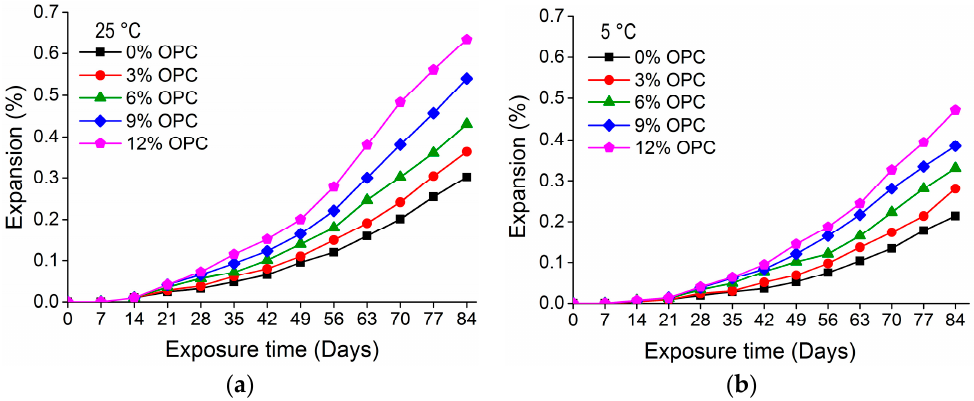
Figure 5. Expansion in nano-TiO 2 containing OPC mortars immersed in 10% Na 2 SO 4 solution at ( a ) 25 ◦ C ( b ) 5 ◦ C.